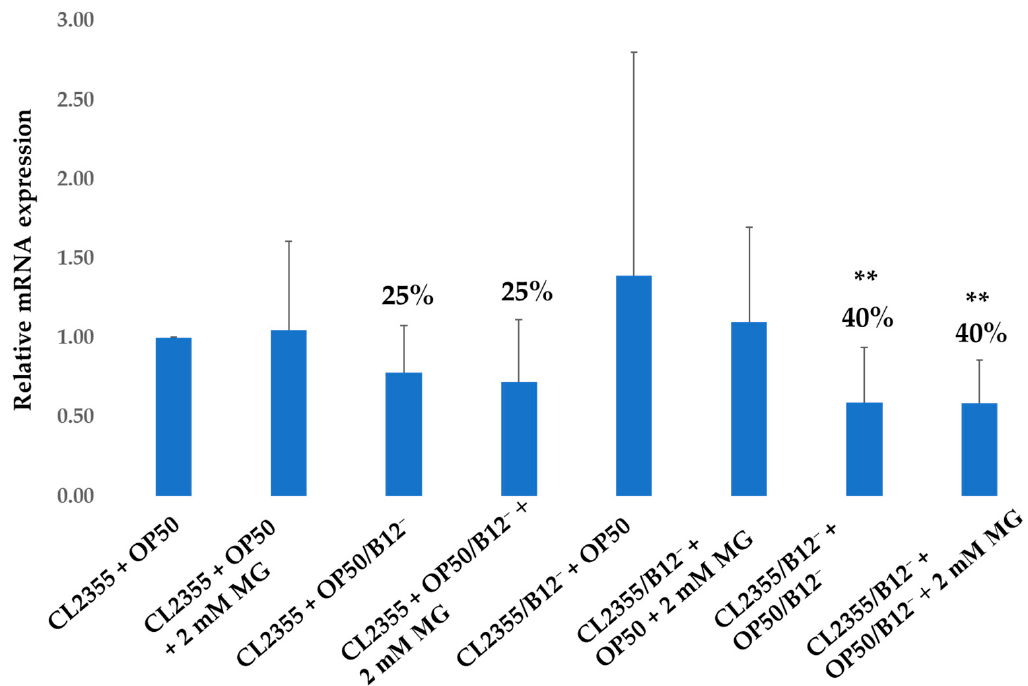
Figure 10. Expression of ace-2 gene on CL2355 and CL2355/B12 − worms fed with either OP50 or OP50/B12 − with or without 2 mM mogrosides (MG). The fold-change (2 − ∆∆ Ct ) and standard deviations of the gene expression were calculated from six independent experiments. All treatments were compared to the control CL2355 fed with only OP50. The Student t -test was conducted to assess the statistical significance (** p < 0.01).